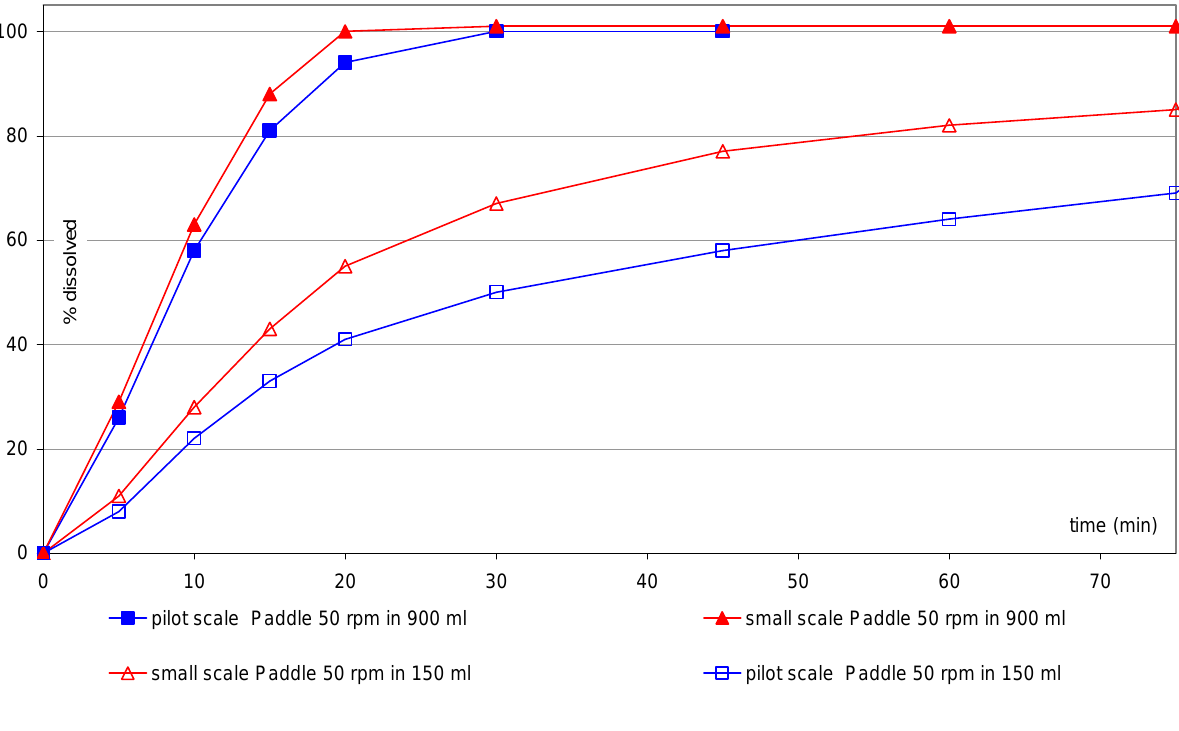
Figure 7. IR(2) tablets: comparison after scale–up using small vessel